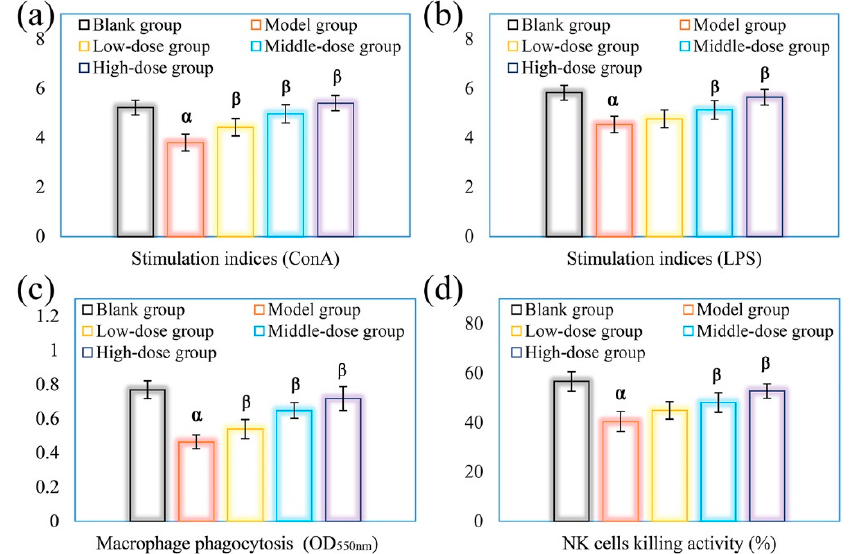
Figure 6. Effects of DOPs on the splenic T lymphocytes proliferations induced by Con A ( a ), the splenic B lymphocytes proliferations induced by LPS ( b ), phagocytic activity of peritoneal macrophages ( c ), and splenic NK cytotoxic activity ( d ) in immunosuppressed mice. Note: α p < 0.05 vs. the blank group; β p < 0.05 vs. the model group.